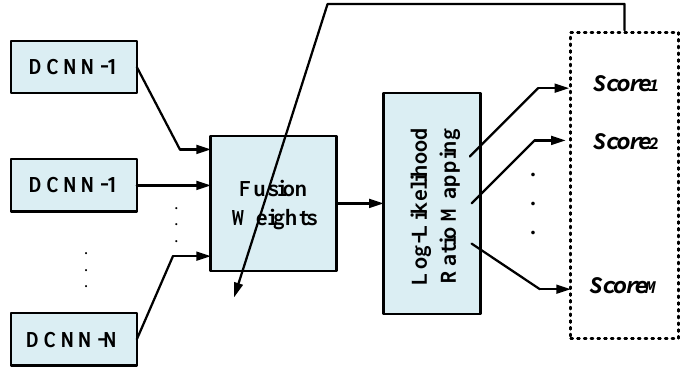
Figure 8. The training paradigm for learning the fusion